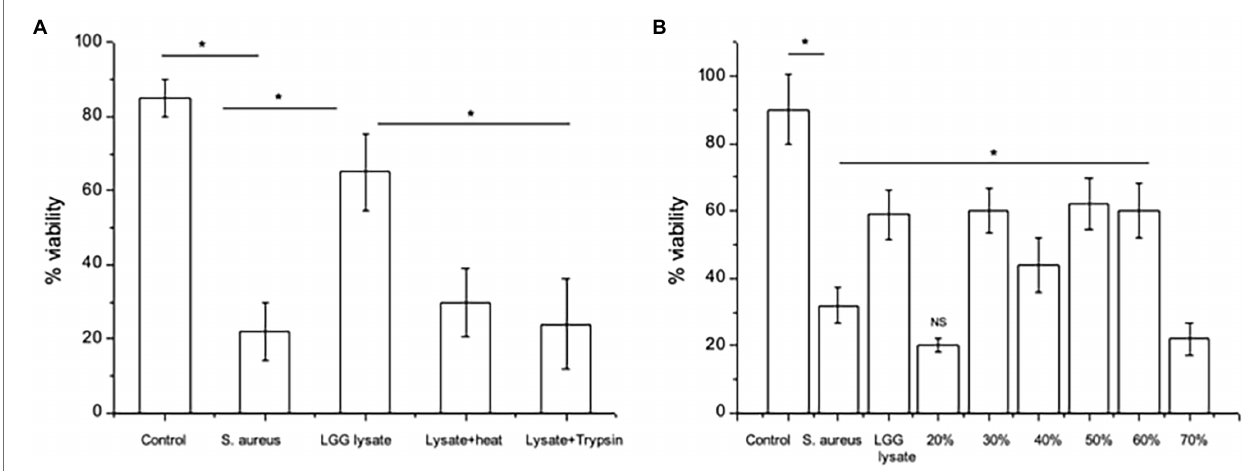
FIGURE 1 | Proteins mediate the effects of LGG lysate against Staphylococcus aureus . (A) A combination of S. aureus and Lacticaseibacillus rhamnosus GG lysate (Lgg lys) resulted in a significantly higher percentage of viable keratinocytes than in monolayers infected with S. aureus alone (* p = 0.006). All data are compared to viability of untreated monolayers (Control). Heat (Lysate + heat) or protease treatment (Lysate + trypsin) destroyed the ability of the lysate to protect keratinocytes from S. aureus . (B) When the lysate was fractionated and proteins eluted in 10–70% acetonitrile, proteins with efficacy against S. aureus were contained in fractions 30–60%. Data were generated using primary human keratinocytes from three different donors and are presented as the mean ± SEM, n = 3. ns =